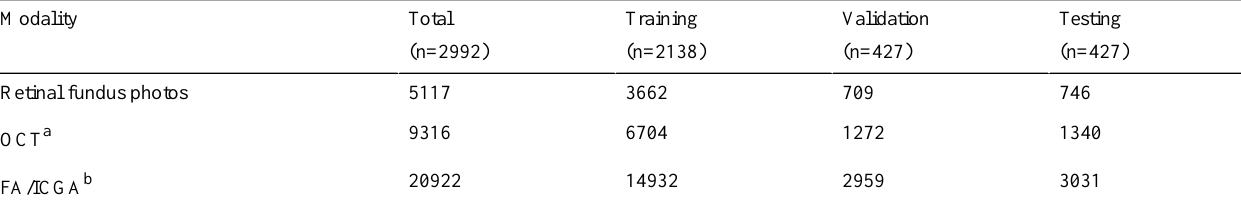
Table 2. Distribution of image number used in different modalities for different data